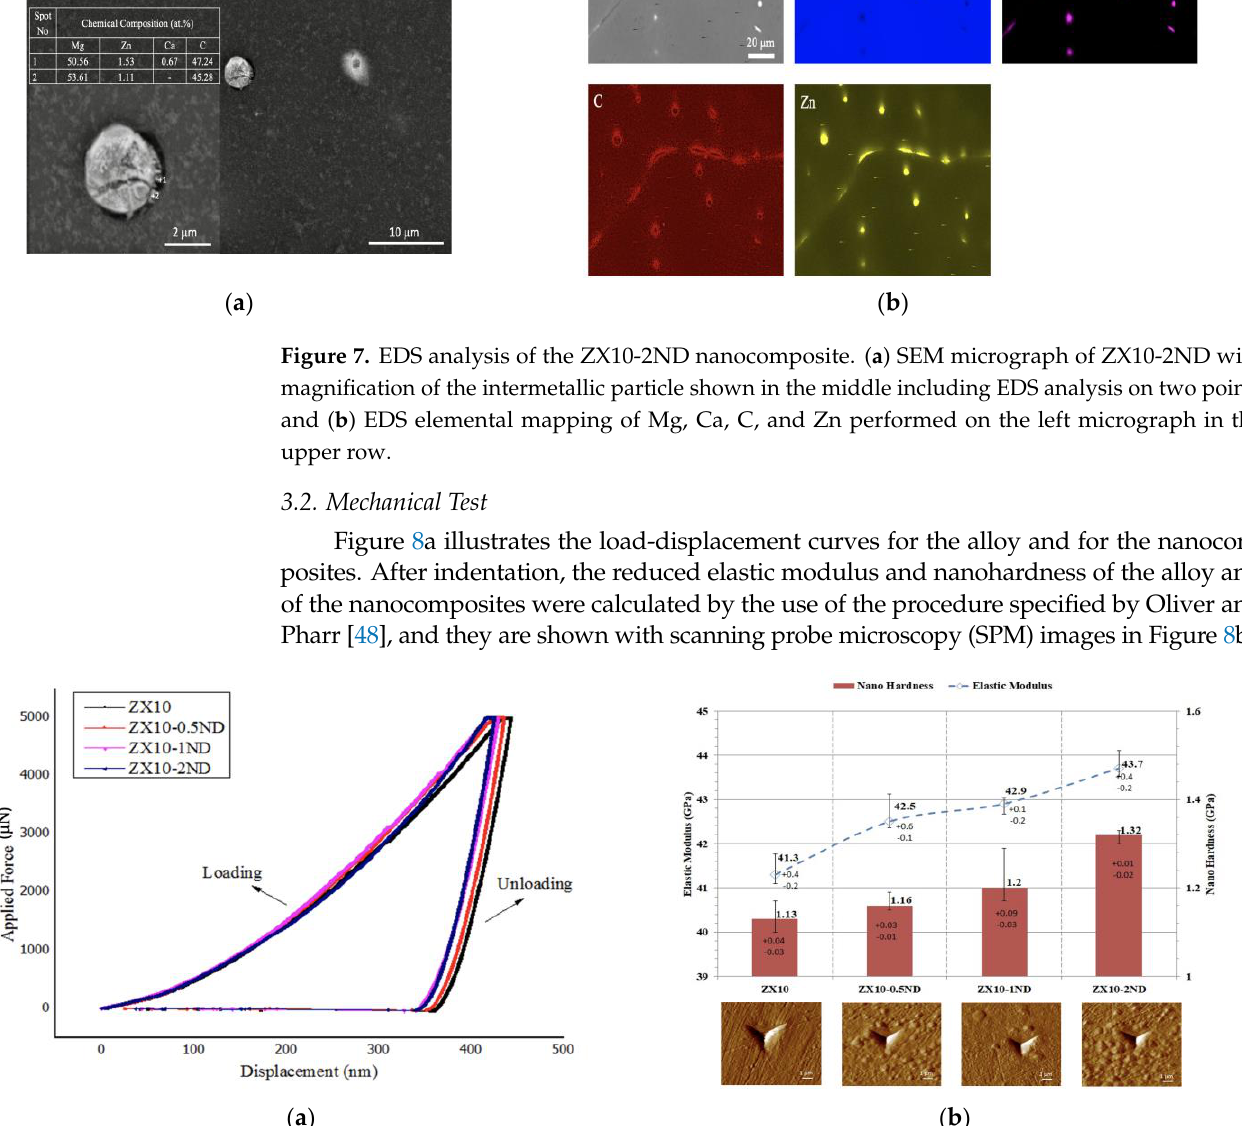
Figure 8. ( a ) Load-displacement curves of the ZX10 alloy and ZX10-0.5ND, ZX10-1ND, and ZX10- 2ND nanocomposites; ( b ) nano-hardness values and reduced elastic modulus of the ZX10 alloy and ZX10-0.5ND, ZX10-1ND, and ZX10-2ND nanocomposites with scanning probe microscopy (SPM) images (10 × 10 µm 2 ) after a nanoindentation test.